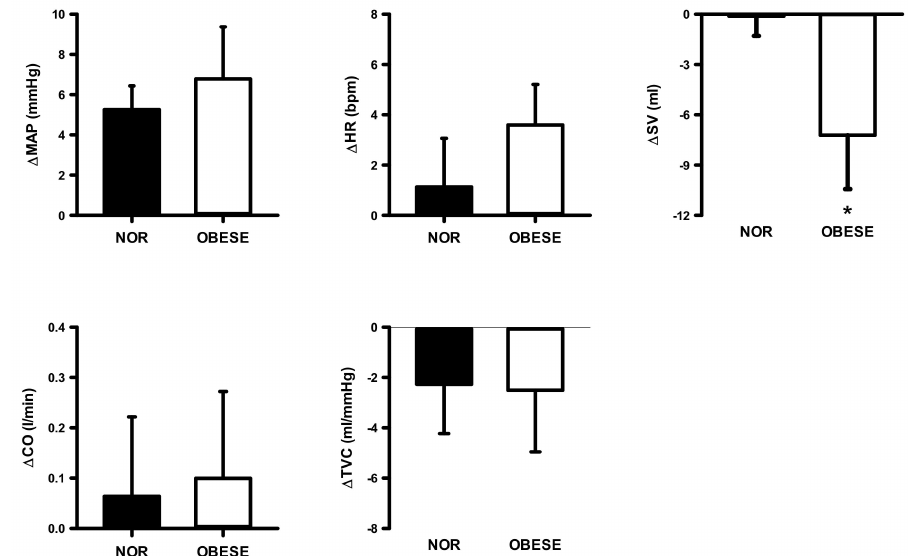
Figure4. Changesfromrestinmeanarterialpressure(MAP),heartrate(HR),strokevolume(SV),cardiac output (CO), and total vascular conductance (TVC) during post-exercise muscular ischemia (PEMI) in normal and obese individuals. Black bar, normal; open bar, obese. * p < 0.05, vs. normal